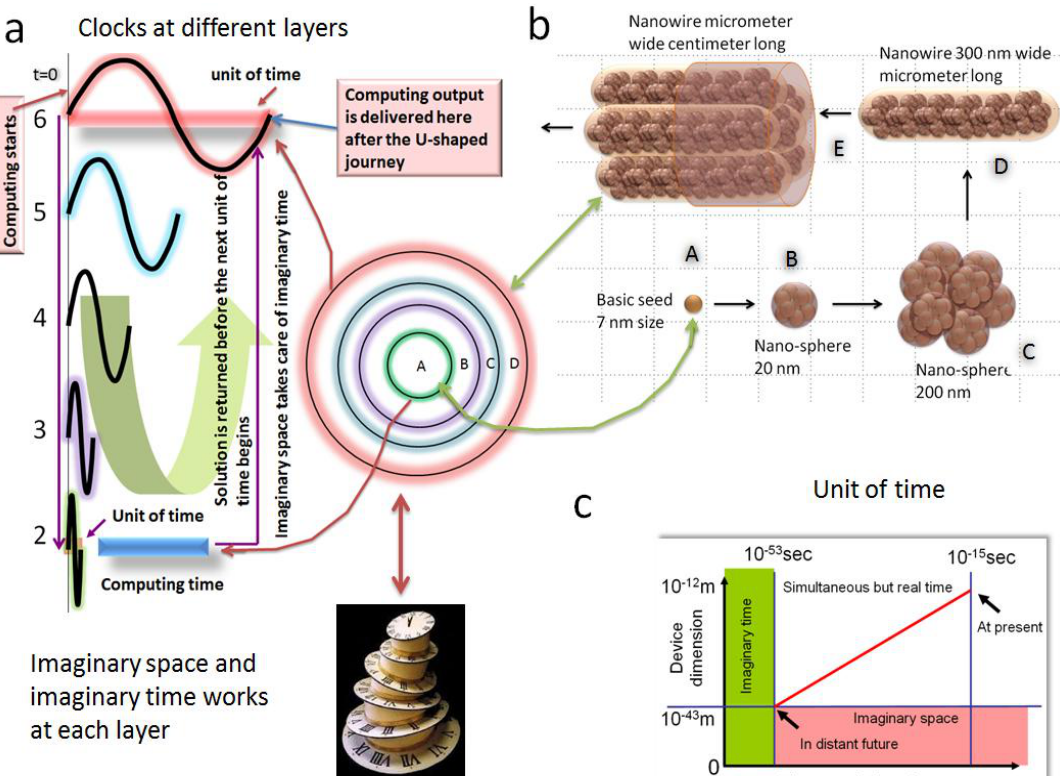
Figure 1. ( a ) Resonance frequency limits construct clocks at different layers, layer 2 = A (highest frequency region, clock is very fast), layer 3 = B; layer 4 = C; layer 5 = D; layer 6 = E (lowest frequency region, clock is very slow); ( b ) A is basic seed, it assembles into B, several B makes C, several C makes D, several D makes E; ( c ) Development of computing speed, current situation and the ultimate